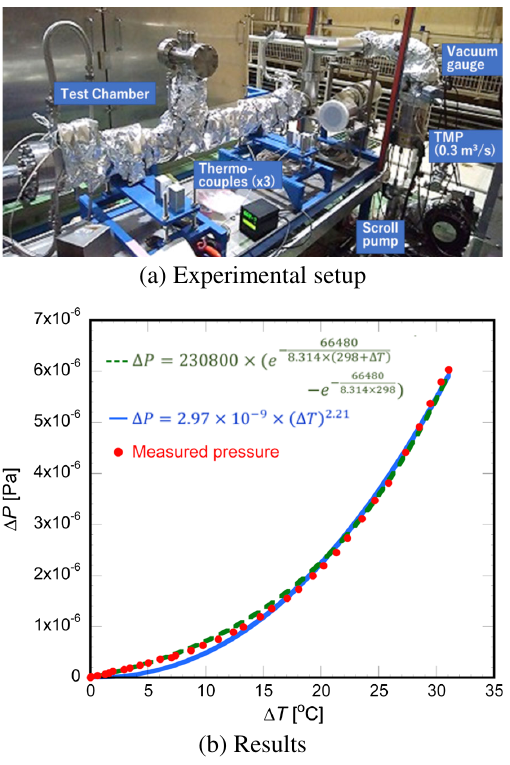
FIG. 9. (a) Experimental setup to measure the dependence of Δ P Δ T , and (b) the measured results and calculated Δ P t on using the regression curves derived assuming Eqs. (4) and